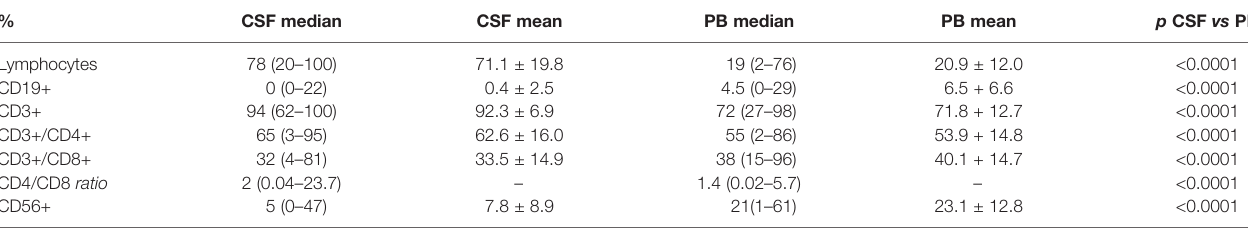
Values are expresses as a percentage of CD45-positive lymphocytes. Wilcoxon rank-sum test was conducted to evaluate the different distribution between CSF and PB lymphoid subpopulations.